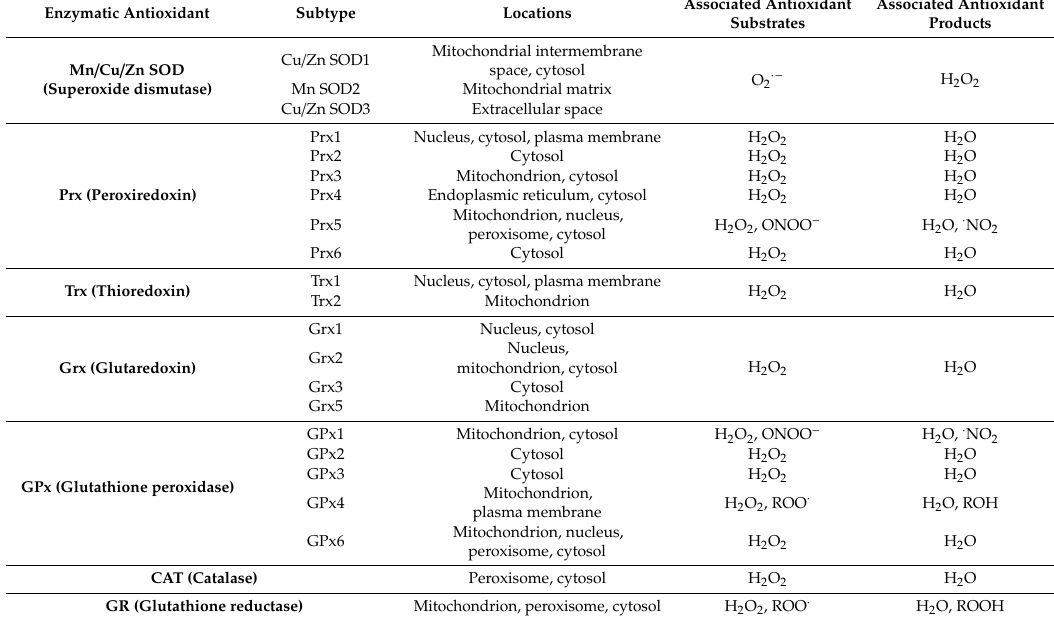
Table 1. A list and a brief description of the representative enzymatic antioxidants.